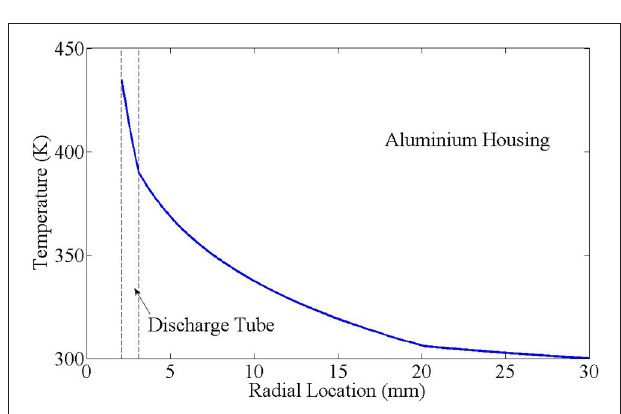
FIGURE 6 | Radial temperature profile for Pocket Rocket housing after 20 s of